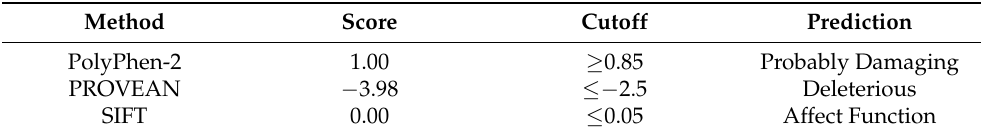
Table 2. Effect of L101F substitution on Mt GidB